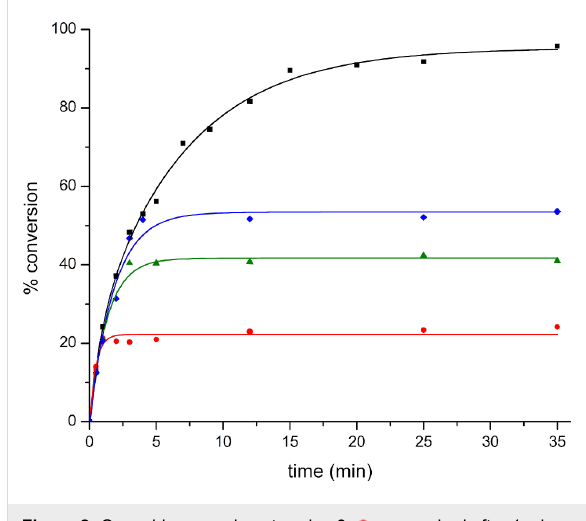
Figure 2: Quenching experiments using 9 . = quenched after 1 min; = quenched after 3 min; = quenched after 5 min.